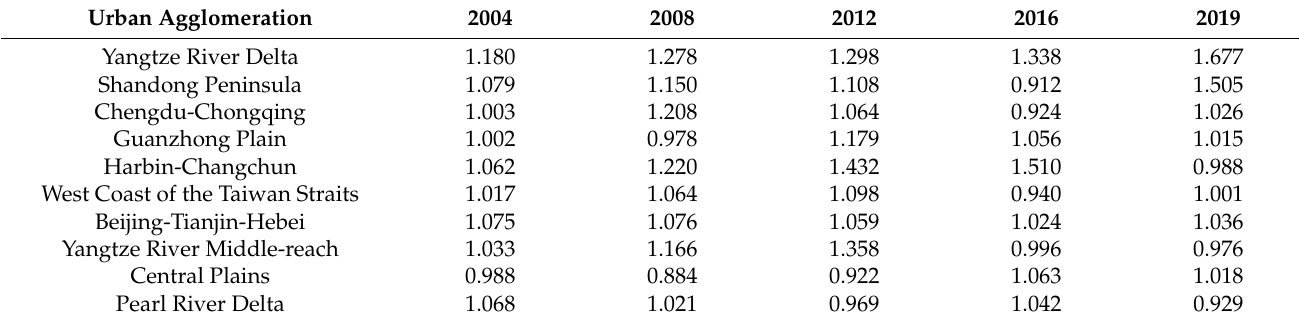
Table 3. ULUE values of top ten urban agglomerations in specific years.